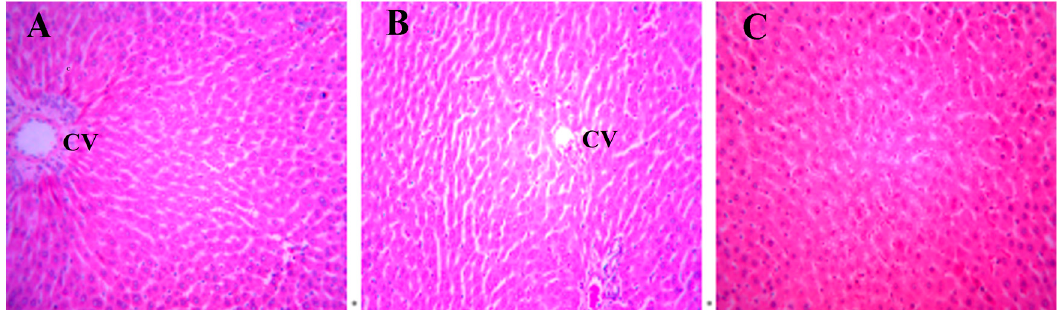
Figure 2. Changes in the hepatocytes stained with hematoxylin and eosin (H.E.) after DBDCT exposure (magnification: 20 × ). ( A ) H.E.-stained image of the control hepatocytes. A H.E.-positive reaction is evenly seen from the central vein (CV); ( B ) H.E.-stained image of hepatocytes with the treatment of the solvent. The images of the hepatocytes treated with the solvent are almost identical to those of the control group; ( C ) The images of the hepatocytes treated with DBDCT (5.0 mg/kg). After exposure to DBDCT, cell areas were swollen, and vacuoles, pyknosis, cell fusion and denucleation were visible.